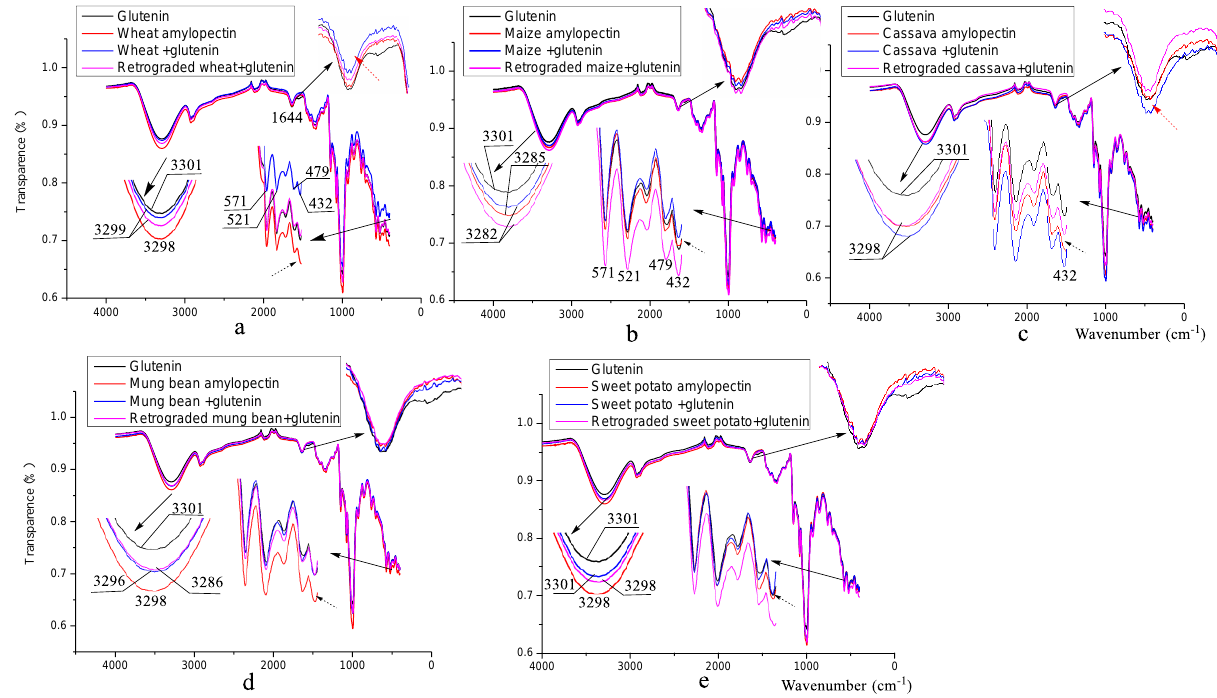
Figure 1. FT-IR spectra of different amylopectins mixed with and without alkali-soluble glutenin. The subfigures are the graphs of a particular peak magnified by a factor of 5–10. ( a ) wheat amylopectin group, ( b ) maize amylopectin group, ( c ) cassava amylopectin group, ( d ) mung bean amylopectin group, ( e ) sweet potato amylopectin group. Result for glutenin (alkali-soluble glutenin) in Figure 1a–e is from the same sample, addition of it in every figure is to facilitate comparative analysis. The typical protein bands for amide I (80% C=O stretch, 10% C-N stretch) at ~1633 cm − 1 and amide II (60% N-H bend, 30% C-N stretch and 10% C-C stretch) at ~1529 cm − 1 are all very weak, and bands only appear at around ~1644 cm − 1 . Such bands are assigned to